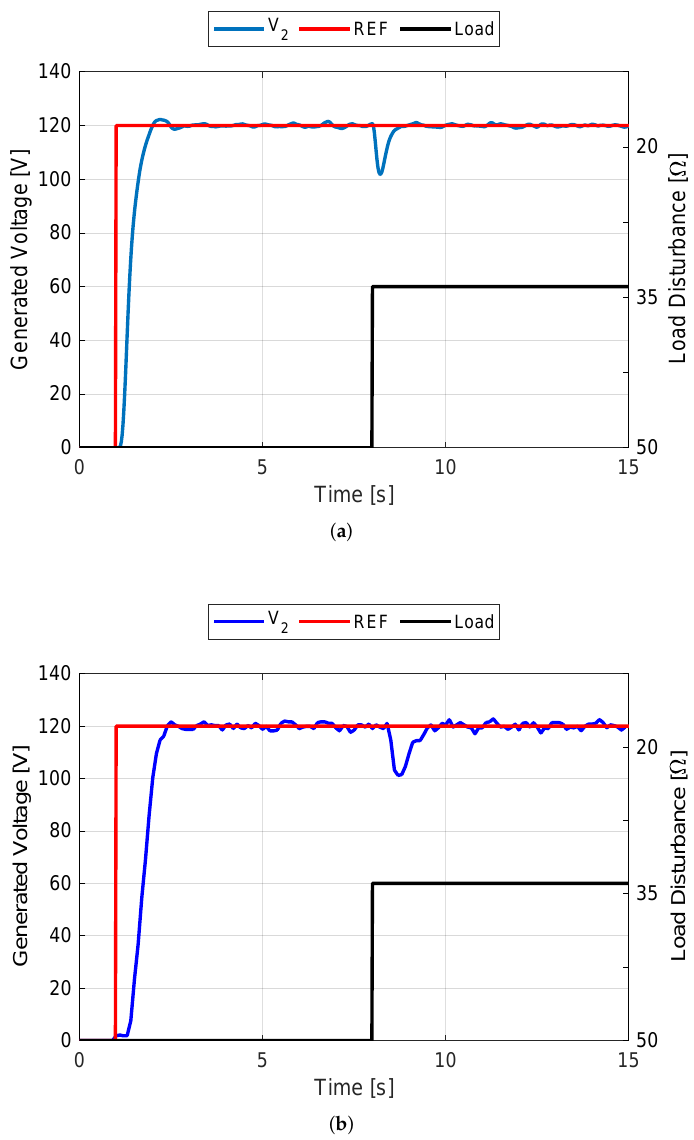
Figure 10. Voltage PID controller response using V 1 as manipulated variable (120 V reference): ( a ) Simulation result and ( b ) experimental